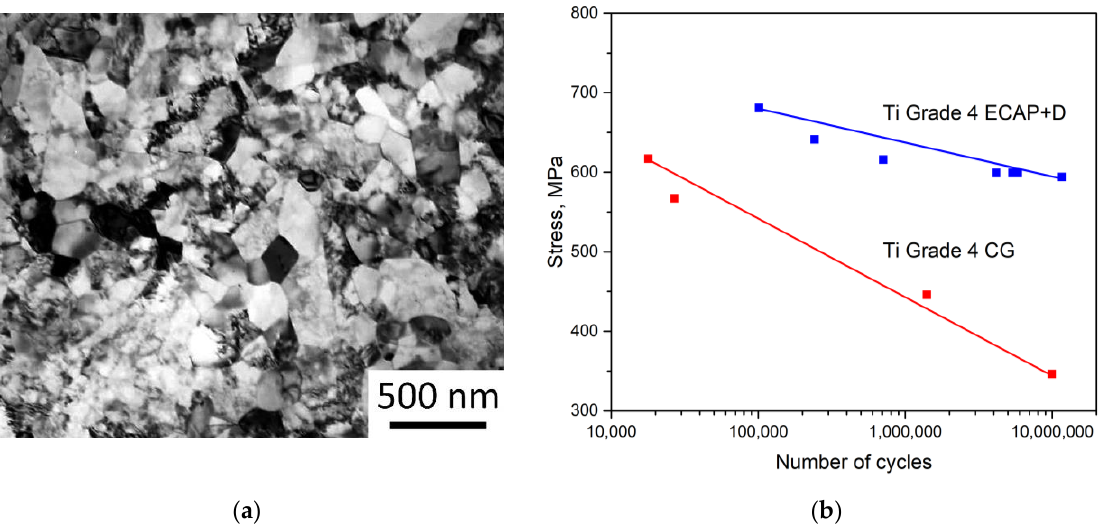
Figure 2. TEM image of the refined microstructure of the CP Ti Grade 4 produced by ECAP-C followed by drawing ( a ); S-N curves for the CG Grade 4 Ti and the UFG Grade 4 Ti reconstructed within ANSYS Workbench FEM software (Canonsburg, PA, USA) in accordance to the data presented in [13] ( b ).